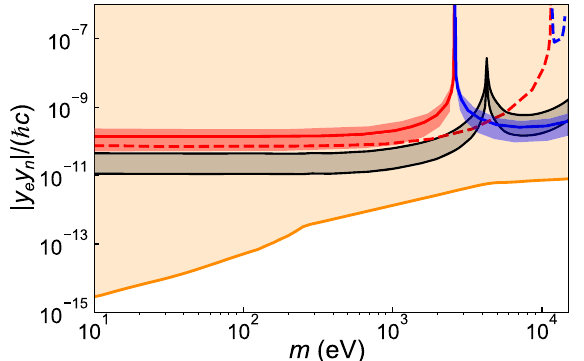
y FIG. 9. Product of couplings j y of a new boson as a e n j function of the mass m . The black shaded region represents the 95% confidence interval of the new physics coupling obtained from the fit using Eq. (11) with h ¼ h . For comparison, the PS constraint from electron anomalous magnetic moment ( g − 2 ) measurements combined with neutron scattering measurements is shown as the orange shaded region, as in Fig. 8. In addition, the favored regions and constraints from Yb þ analysis [12] are shown as red and blue lines and shaded regions, in exactly the same manners as in Ref.